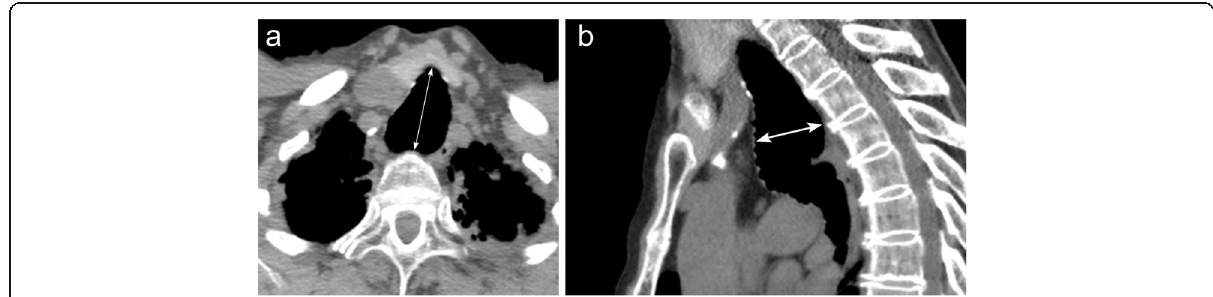
Fig. 19 Tracheobronchomegaly. Axial ( a ) and sagittal ( b ) noncontrast CT images of the thoracic inlet demonstrating dilatation of the trachea, measuring >3cm as can be seen in the setting of